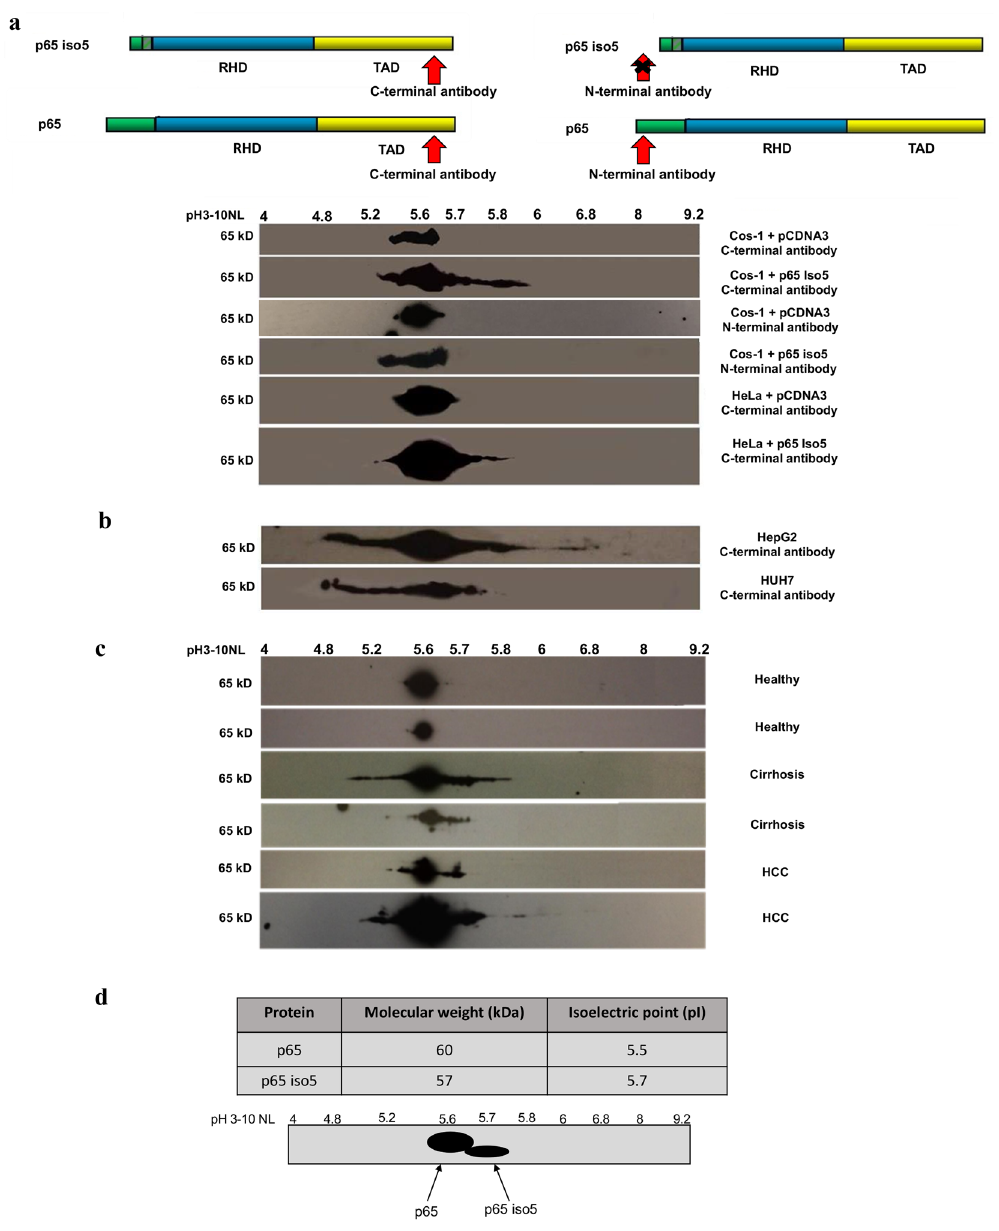
Figure 7. p65 and p65 iso5 protein expression by 2-DE in human liver samples, transfected cell lines and human liver carcinoma cells. ( a ) Expression of p65 and p65 iso5 proteins by 2-DE in Cos-1 and HeLa cells transfected with p65 and p65 iso5 proteins with specific antibodies for C-terminal and N-terminal epitope region. (b ) Expression of p65 and p65 iso5 proteins by 2-DE in HepG2 and HUH7 hepatocarcinoma cell lines. (c ) Electrophoretic pattern of the p65 and p65 iso5 proteins on human liver of healthy, cirrhosis, and hepatocellular carcinoma (HCC) samples. The p65 antibody is specific for an epitope at C-terminal region that is present both in p65 and in p65 iso5 proteins. (d ) Theoretical Molecular weight (Mw) and Isoelectric point (pI) of p65 and p65 iso5. The values were calculated using Compute pI/Mw tool (ExPASy) and do not take into consideration the possible post-translational modifications (PTMs). Schematic representation based on the hypothetical pI and Mw of the p65 and p65 iso5 protein pattern on 2D-PAGE. The full length images of 2-DE are available in the “Supplementary Information”